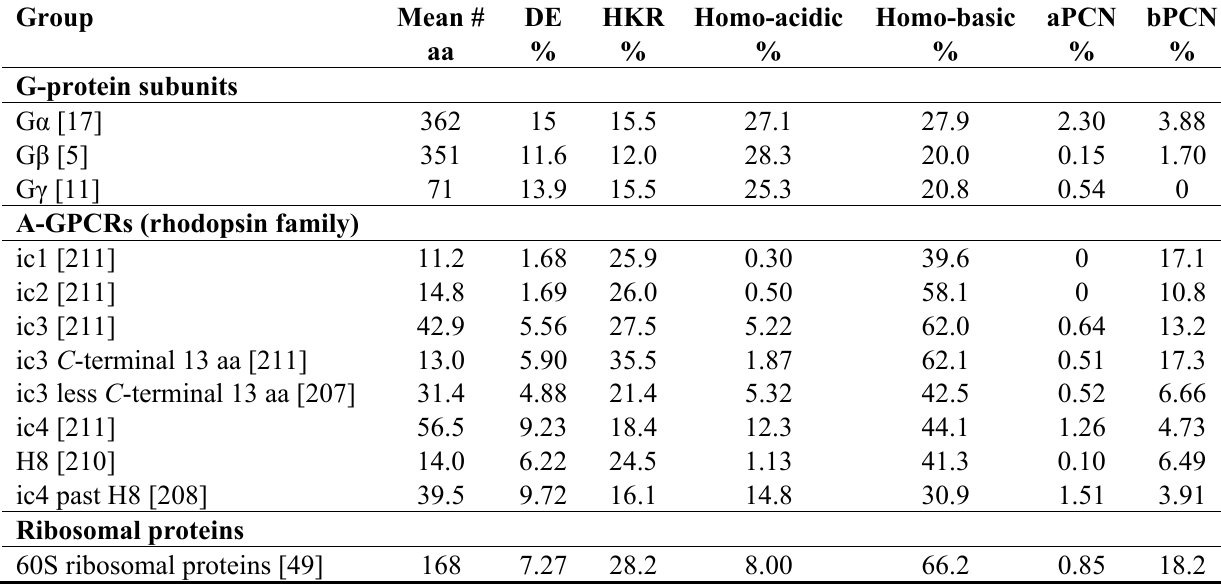
Table 3. A comparison of ionic constituents in human G-proteins, intracellular domains of A-GPCRs and 60S ribosomal